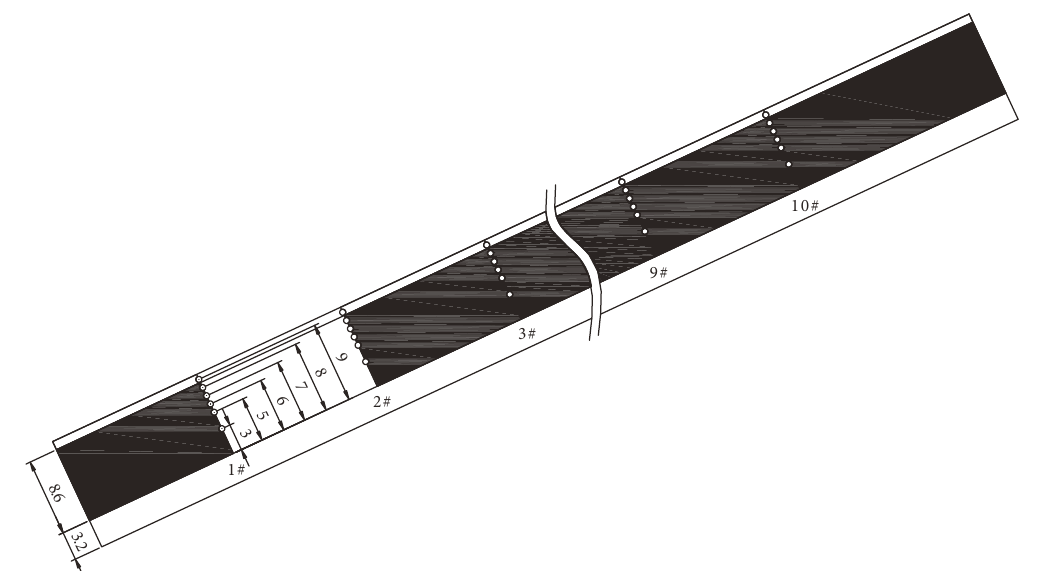
Figure 14: Layout of the monitoring sections and measuring points (unit: (m)).